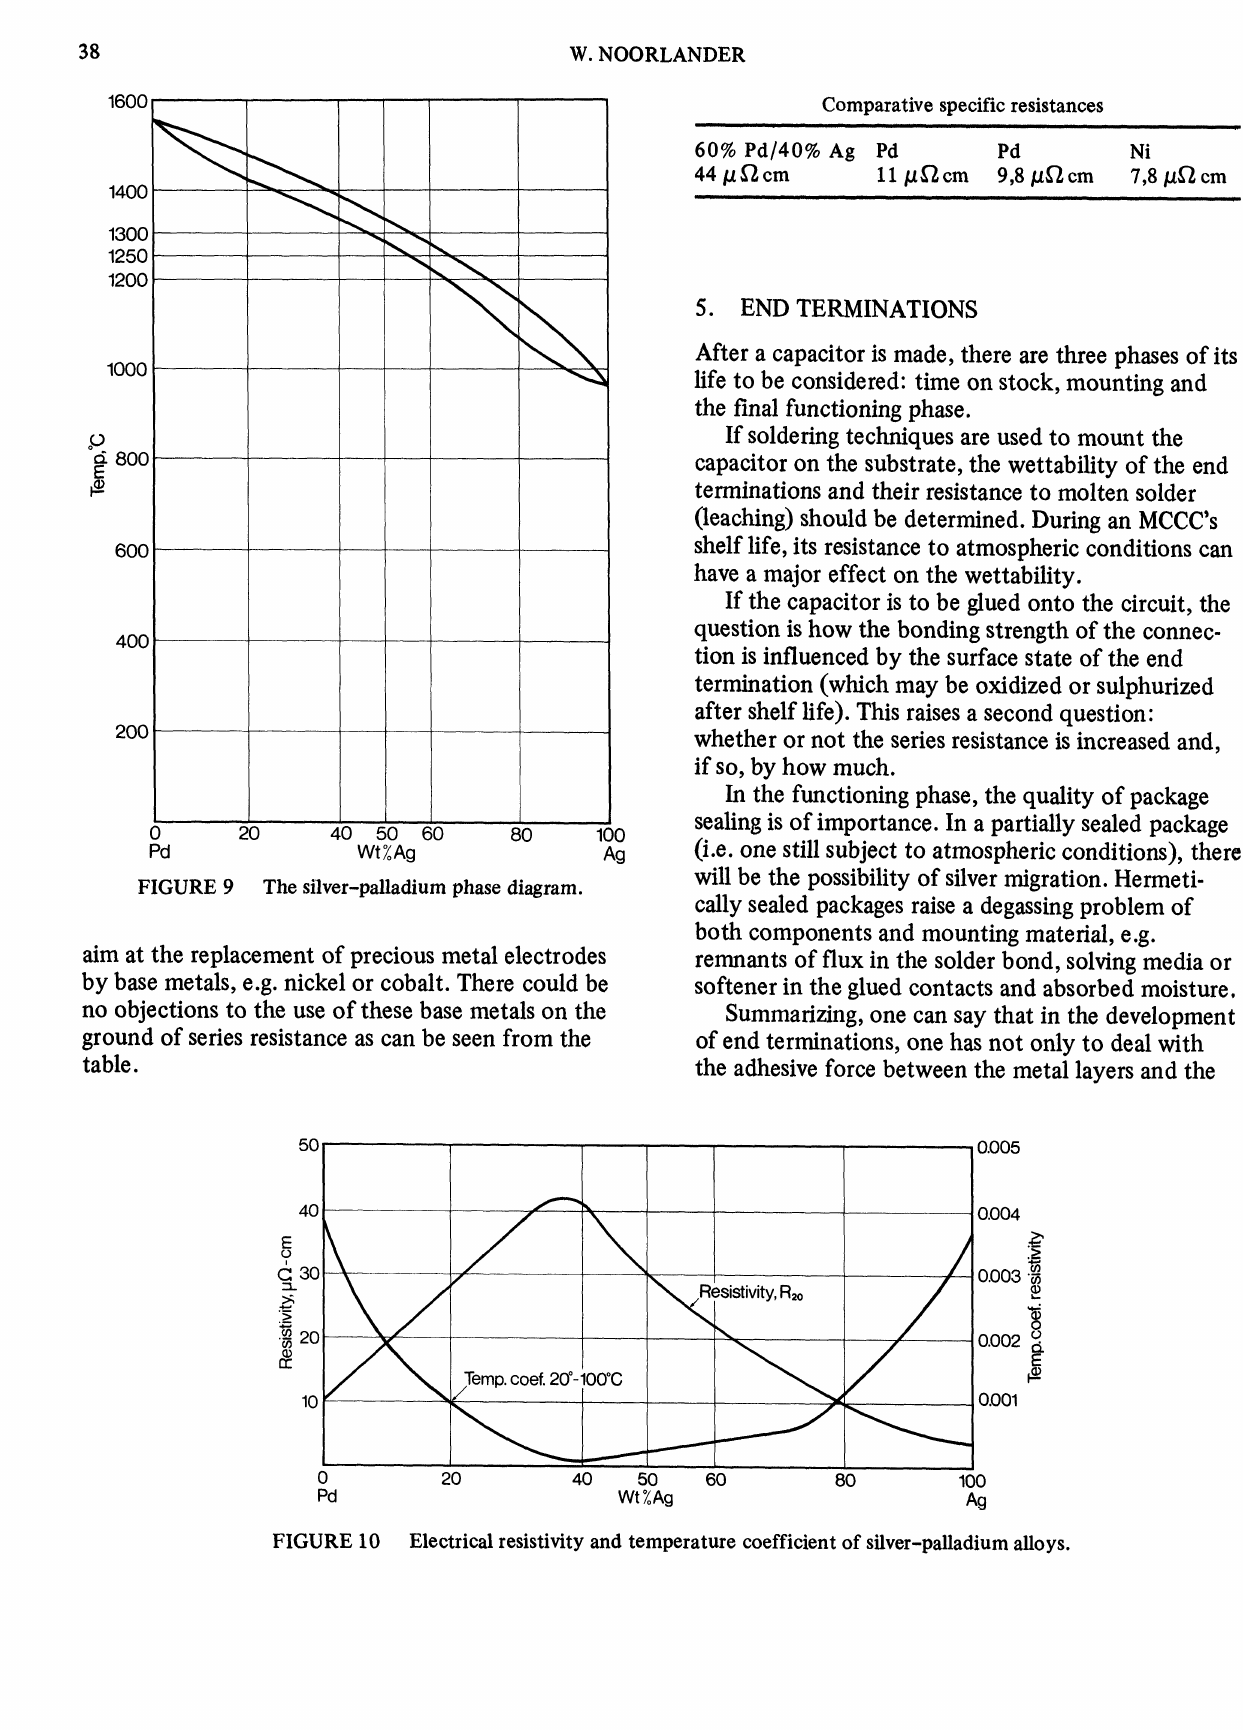
FIGURE 10 Electrical resistivity and temperature coefficient of silver-palladium